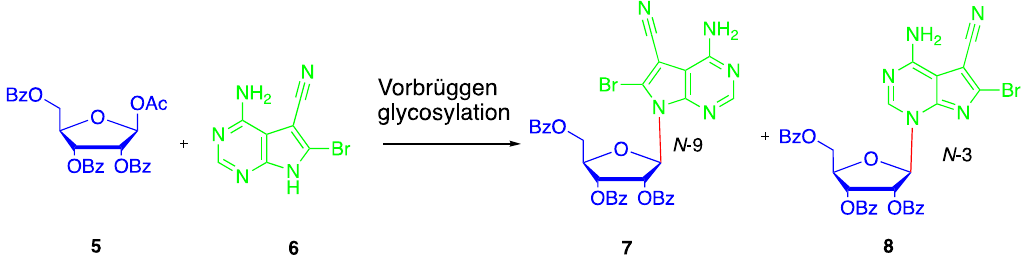
Figure 2. Synthesis of 7-deazapurine nucleosides by Vorbrüggen glycosylation.